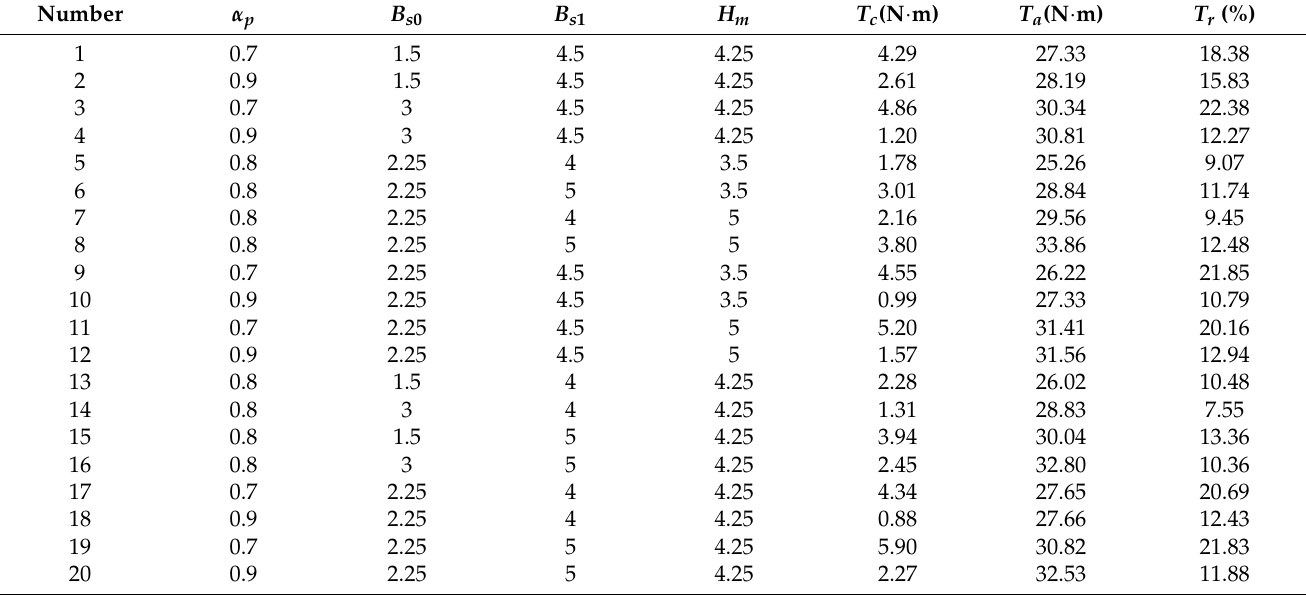
Table 3. BBD test design table and numerical analysis